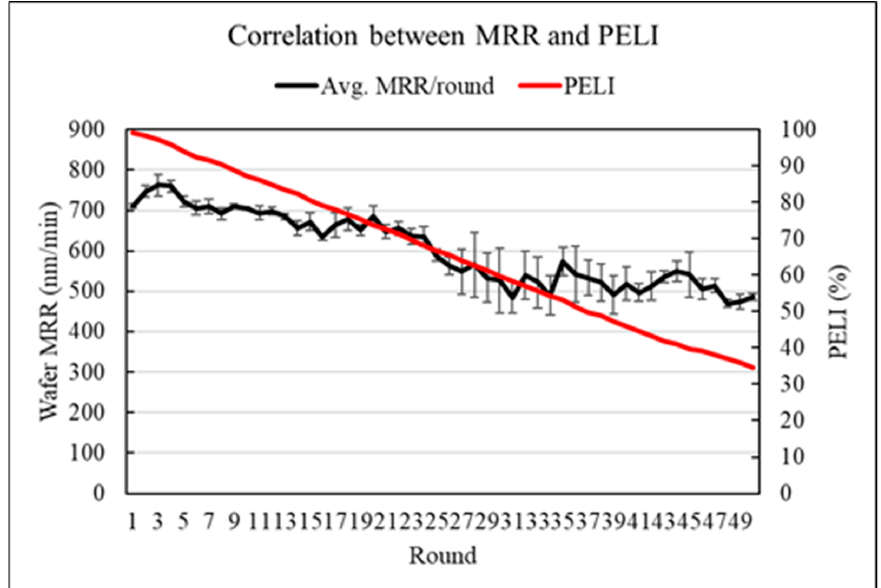
Figure 15. The correlations between MRR and PELI.